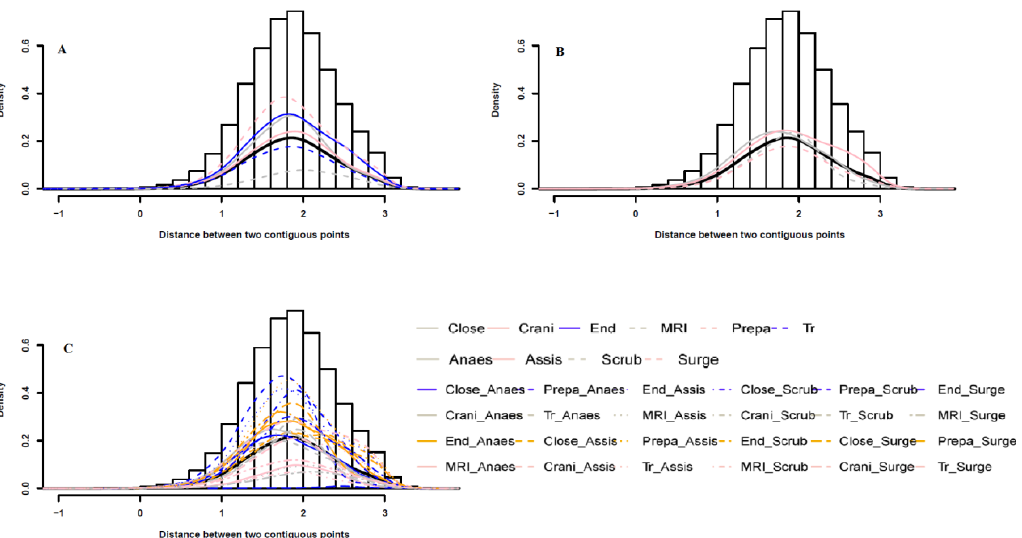
Figure 3. Probability distributions of distance between any two continuous points per surgical role per surgical phase. ( A ) probability distributions of distance per surgical phase; ( B ) probability distributions of distance per surgical role; ( C ) probability distributions of distance per surgical role per surgical phase.